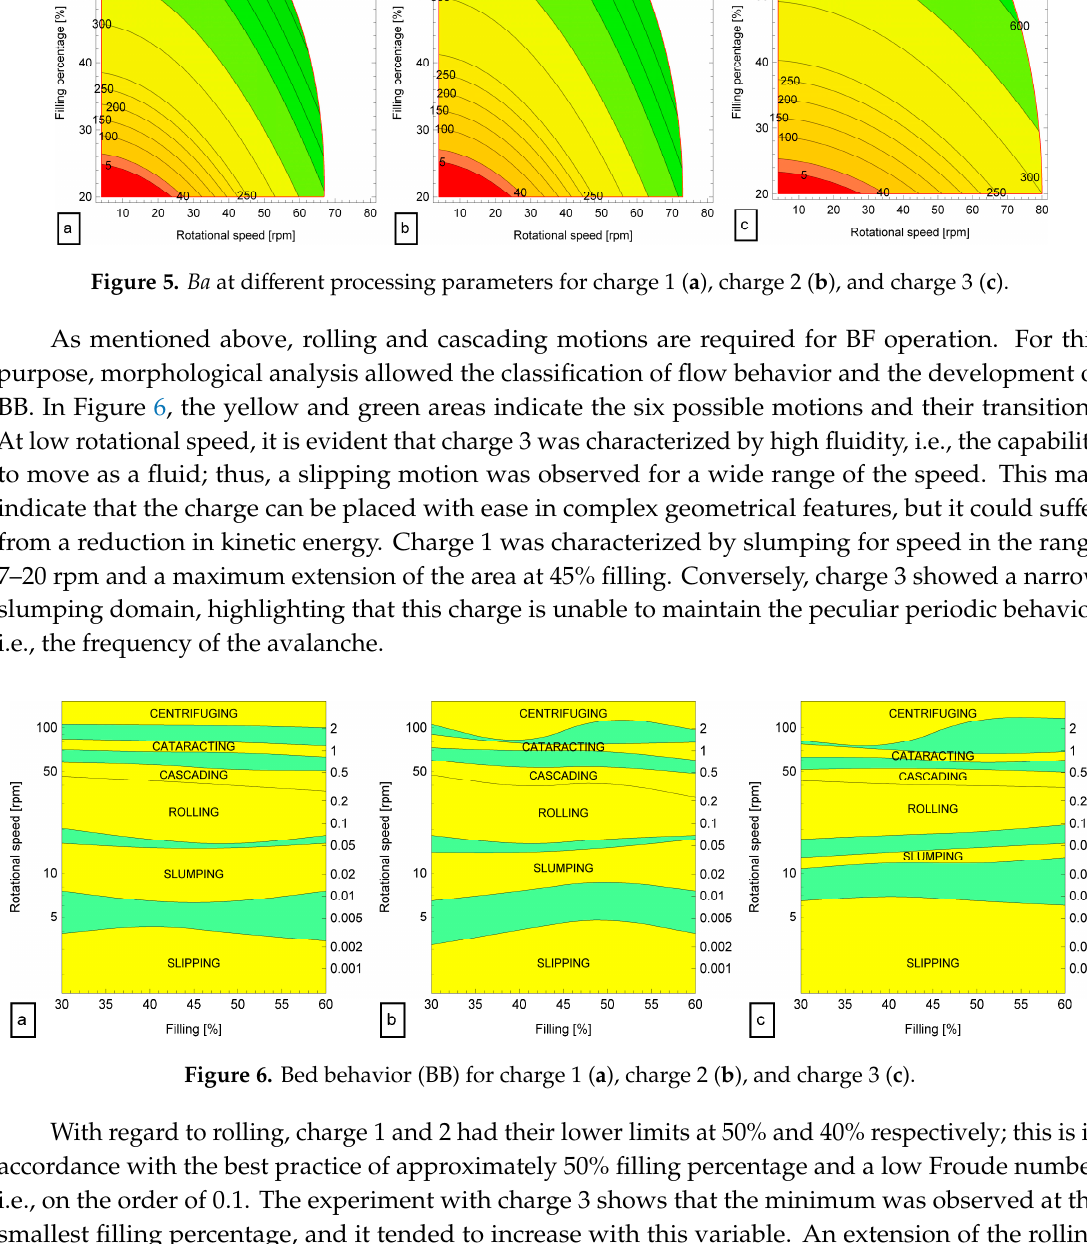
Figure 5. (cid:1828)(cid:1853) at different processing parameters for charge 1 ( a ), charge 2 ( b ), and charge 3 ( c ).